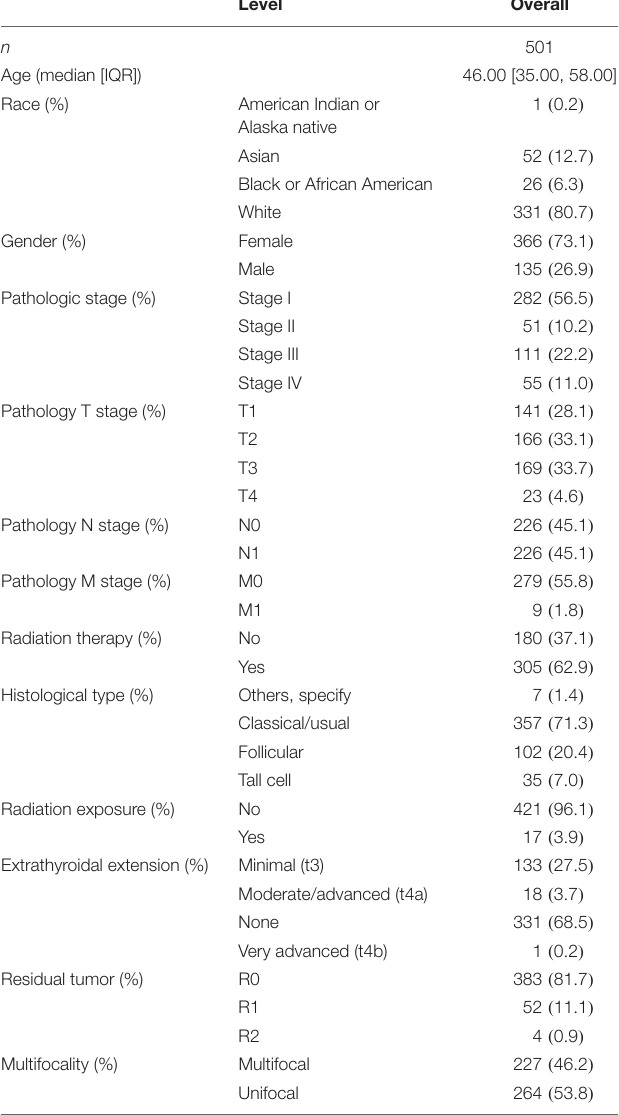
TABLE 1 | Baseline of patients in the TCGA